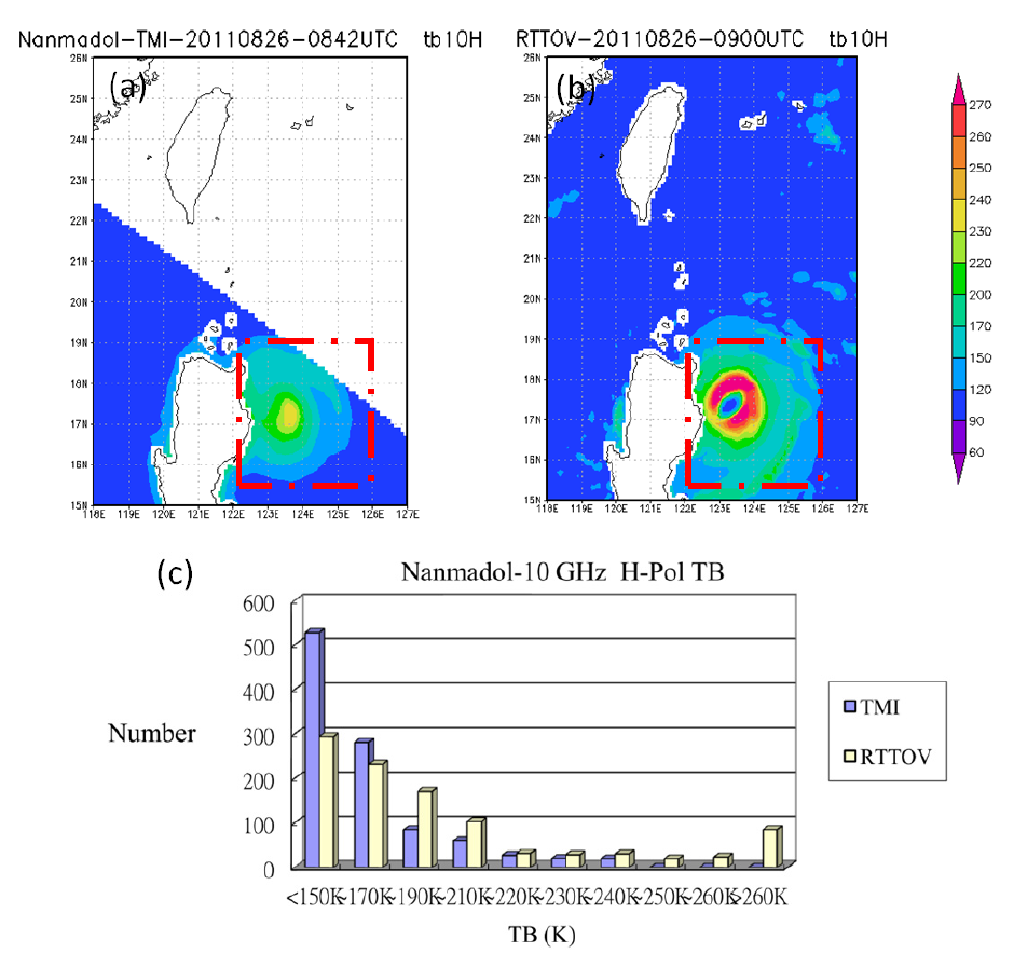
Figure 12. TB10H of Typhoon Nanmadol: ( a ) TMI observation; ( b ) RTTOV simulation; and ( c ) histogram for the region within the dashed square in the preceding